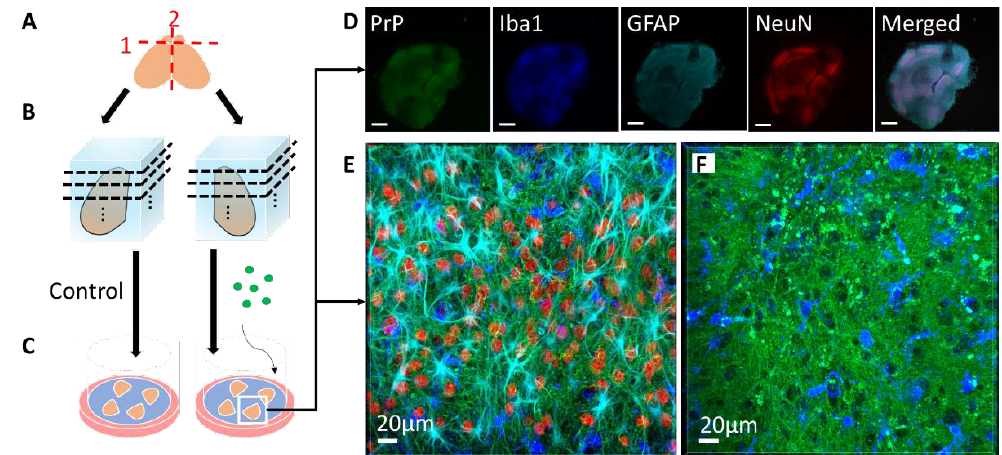
Figure 1. Schematic of coronal slice culture preparation, infection, and confocal imaging. A ) The brain is removed from 8- or 9-day-old mouse pups, the olfactory bulbs are removed, and the brain is hemisectioned sagitally. B ) The hemispheres are embedded in low-melting-point agarose gel and sliced into 275 µm-thick coronal sections with a vibratome. About 40 slices anterior-posterior are obtained from each mouse , with 4 slices cultured per well. Each well is considered a “region”, from 1 (anterior) to 10 (posterior), each representing 1100 µm. C ) The slices are then placed on Milicell cell culture inserts with the culture media below the membrane and can be cultured for as long as three months. During the culture period, genetically identical, location-matched slices can be used as controls or subjected to different treatment conditions in the absence of the blood ‒ brain barrier, such as infection with different prion strains or treatment with different drugs. At various time points, the slices can be immunostained for confocal imaging. D ) Low magnification confocal image of an RML-infected slice that was cultured for 56 days post-infection. PrP (Saf83) is shown in green, microglia (Iba1) are shown in blue, reactive astrocytes (GFAP) are shown in cyan, neuronal nuclei (NeuN) are shown in red. As seen in the NeuN channel, the boundaries of distinct brain regions are discernable (scale = 500 µm). E ) High magnification confocal image of a neocortical region from the RML-infected slice in E, showing the array of cell types and architecture. F ) High magnification confocal image of an RML-infected slice showing PrP aggregates (green) and activated microglia (blue).